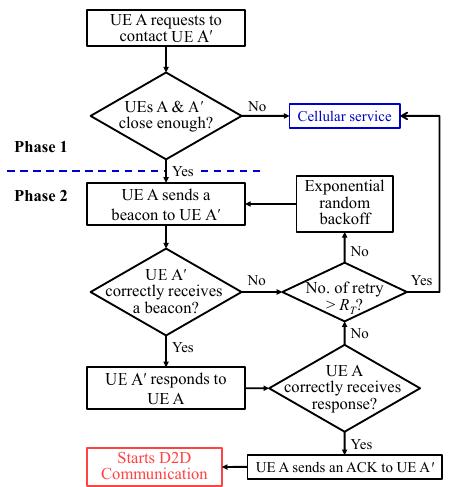
Figure 2. Proposed device-to-device (D2D) discovery algorithm. Phase